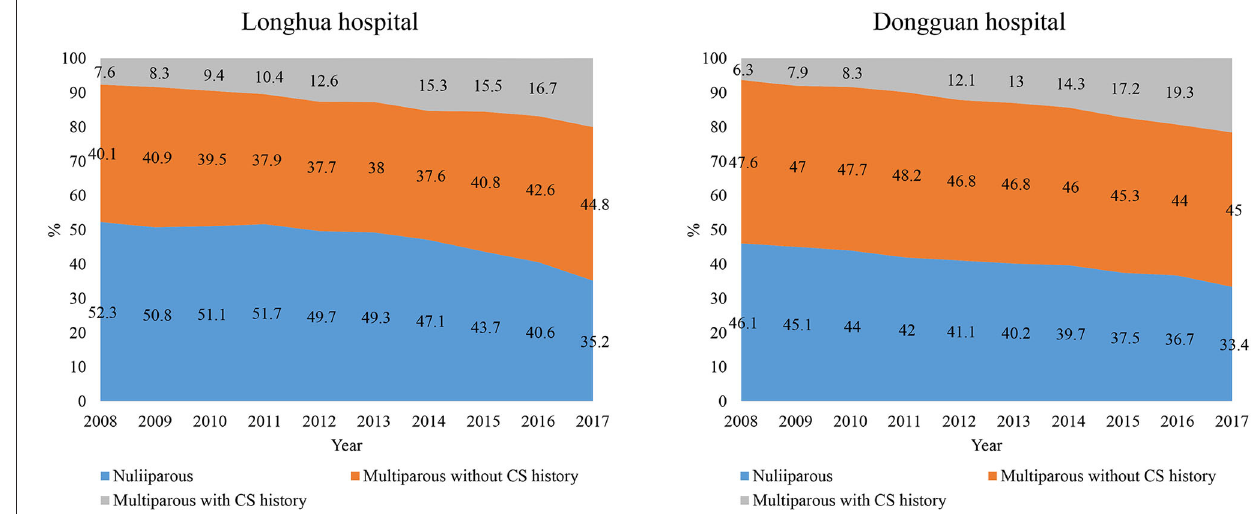
FIGURE 1 | Trends in composition of women by parity and CS history in 10 years from 2008 to 2017 in two hospitals.